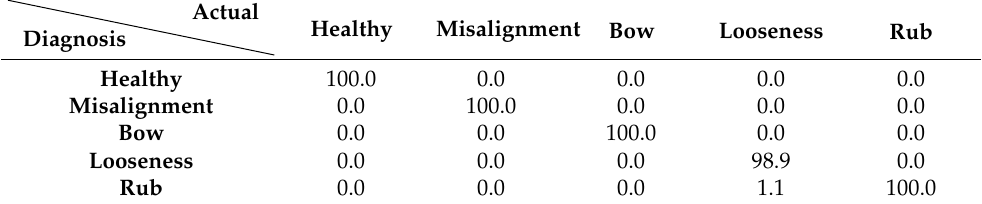
Table 1. Blind application performance (%) at 2400 RPM of the proposed VML model.